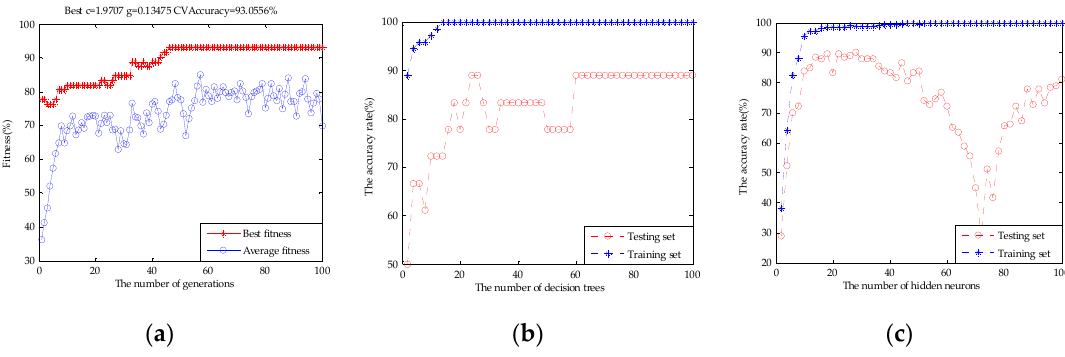
Figure 12. ( a ) The parameter optimization fitness curve of the SVM for the dimensionality reduction set by PCA; ( b ) the classification performance of the RF based on the number of decision trees for the dimensionality reduction set by PCA; and ( c ) the classification performance of the ELM based on the number of hidden neurons for the dimensionality reduction set by PCA.